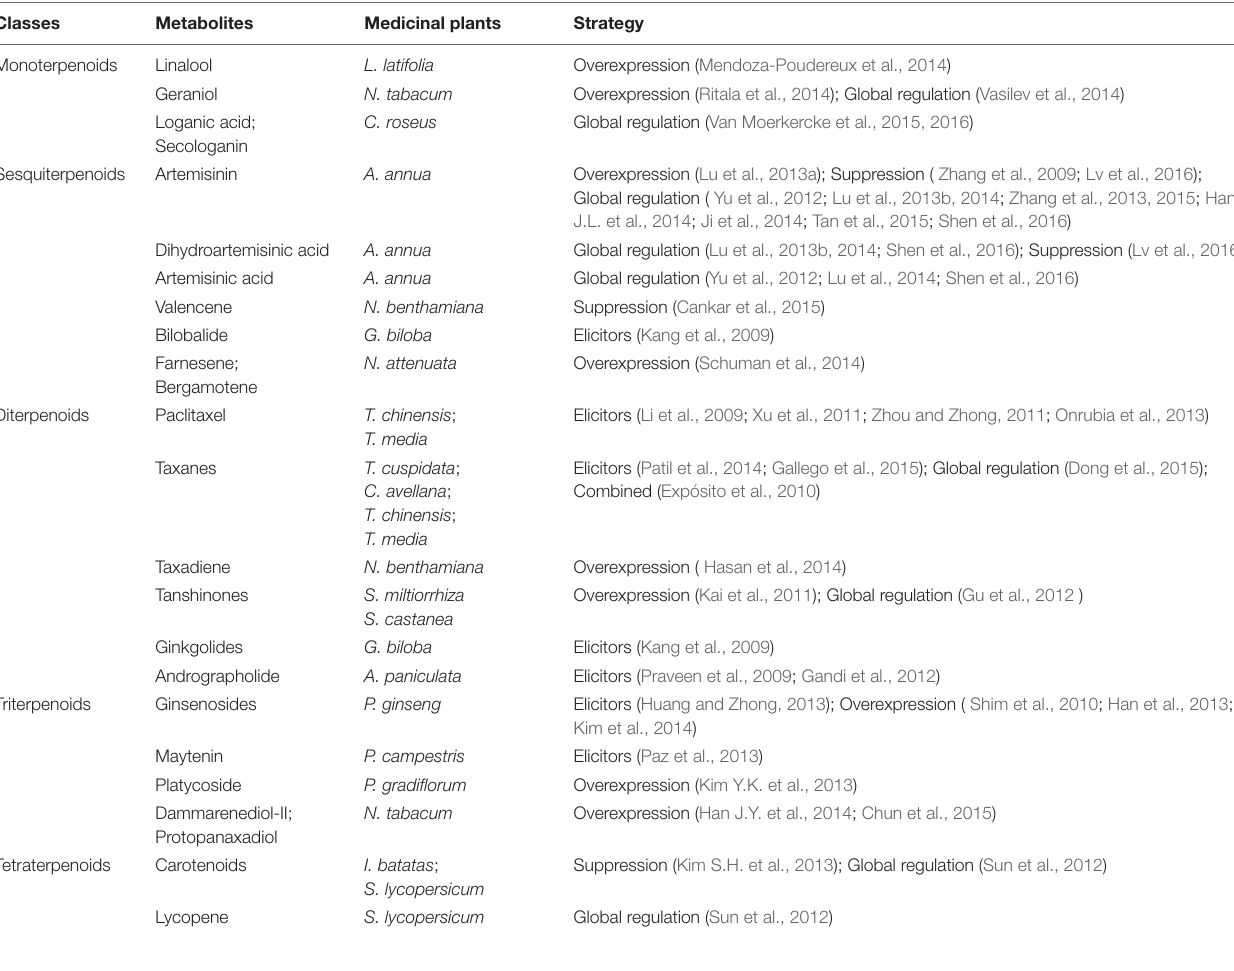
TABLE 1 | Pharmaceutical terpenoids production by plant metabolic engineering